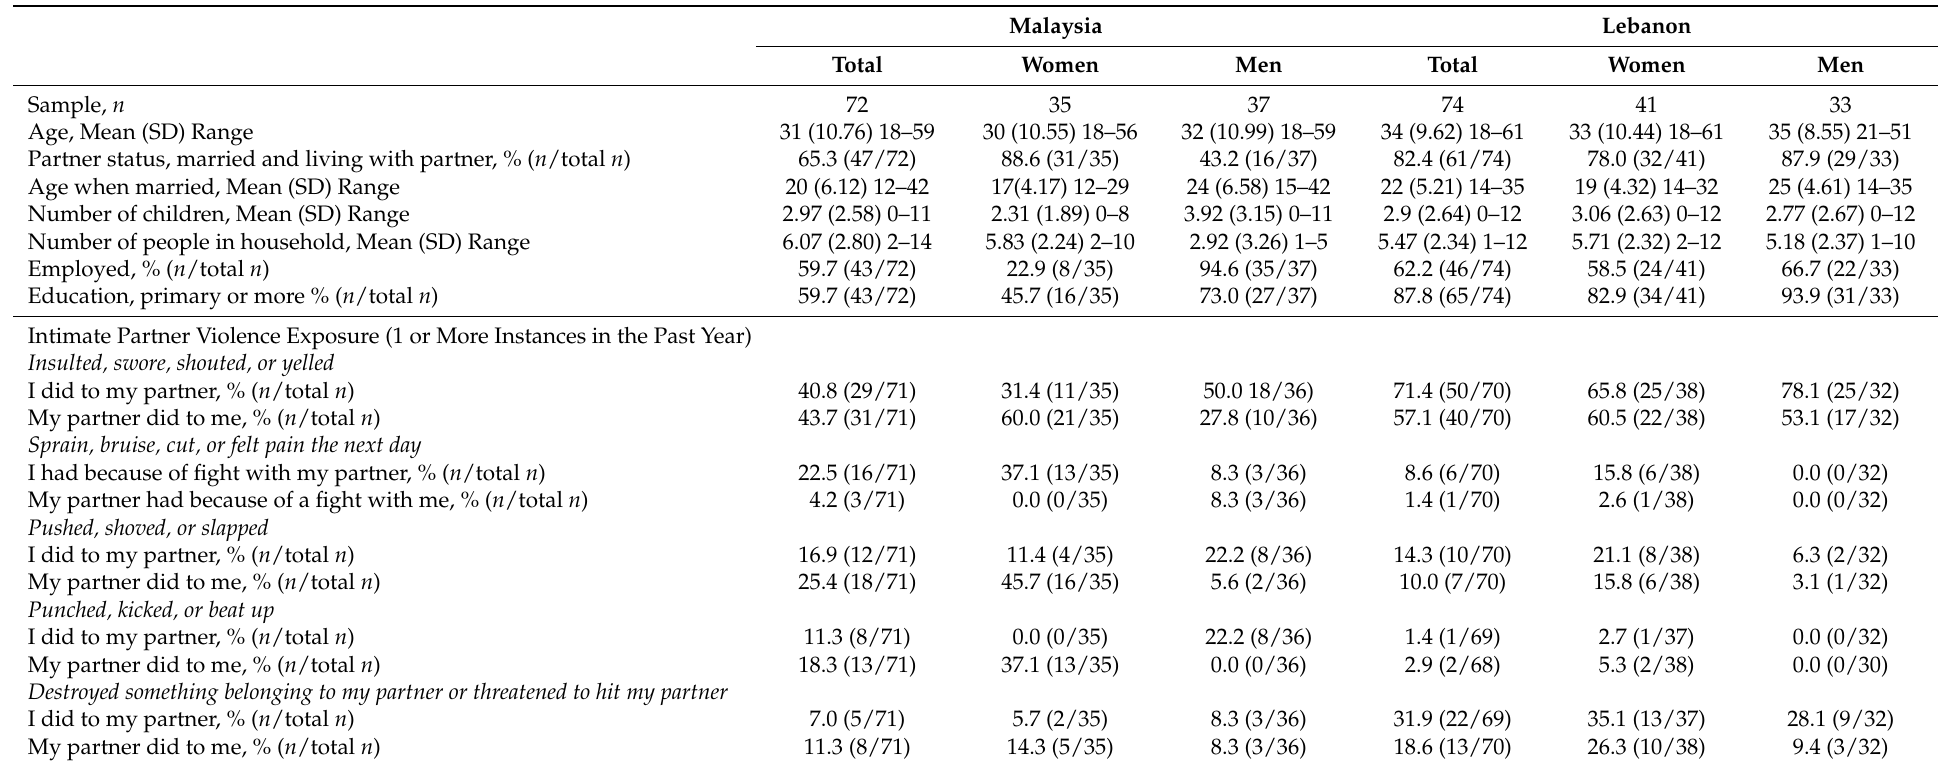
Table 2. Descriptive statistics, workshop